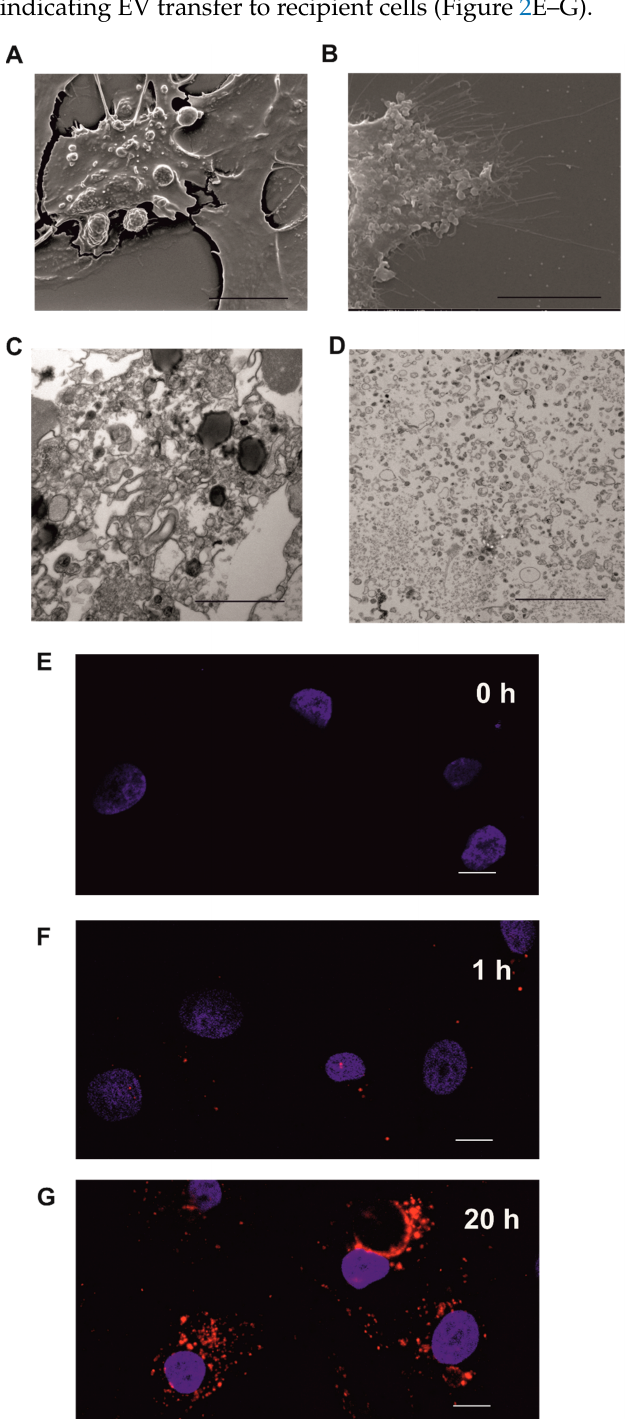
Figure 2. CAF-derived EVs are internalised by normal mesothelial cells. ( A , B ) SEM images of the surface of CAFs ( A ) and NDHFs ( B ). Scale bars, 10 µ m. ( C , D ) TEM of EVs derived from CAFs ( C ) and NDHFs ( D ), pelleted by differential centrifugation. Scale bars, 10 µ m. ( E – G ). Representative z-stack analysis of confocal images depicting internalisation of PKH26-labeled human CAF-derived EVs (red) by LP-9 cells detected by confocal microscopy at 0 h ( E ), at 1 h ( F ) and 20 h ( G ), DAPI (blue). Three independent experiments were performed with similar results. Scale bars, 10 µ